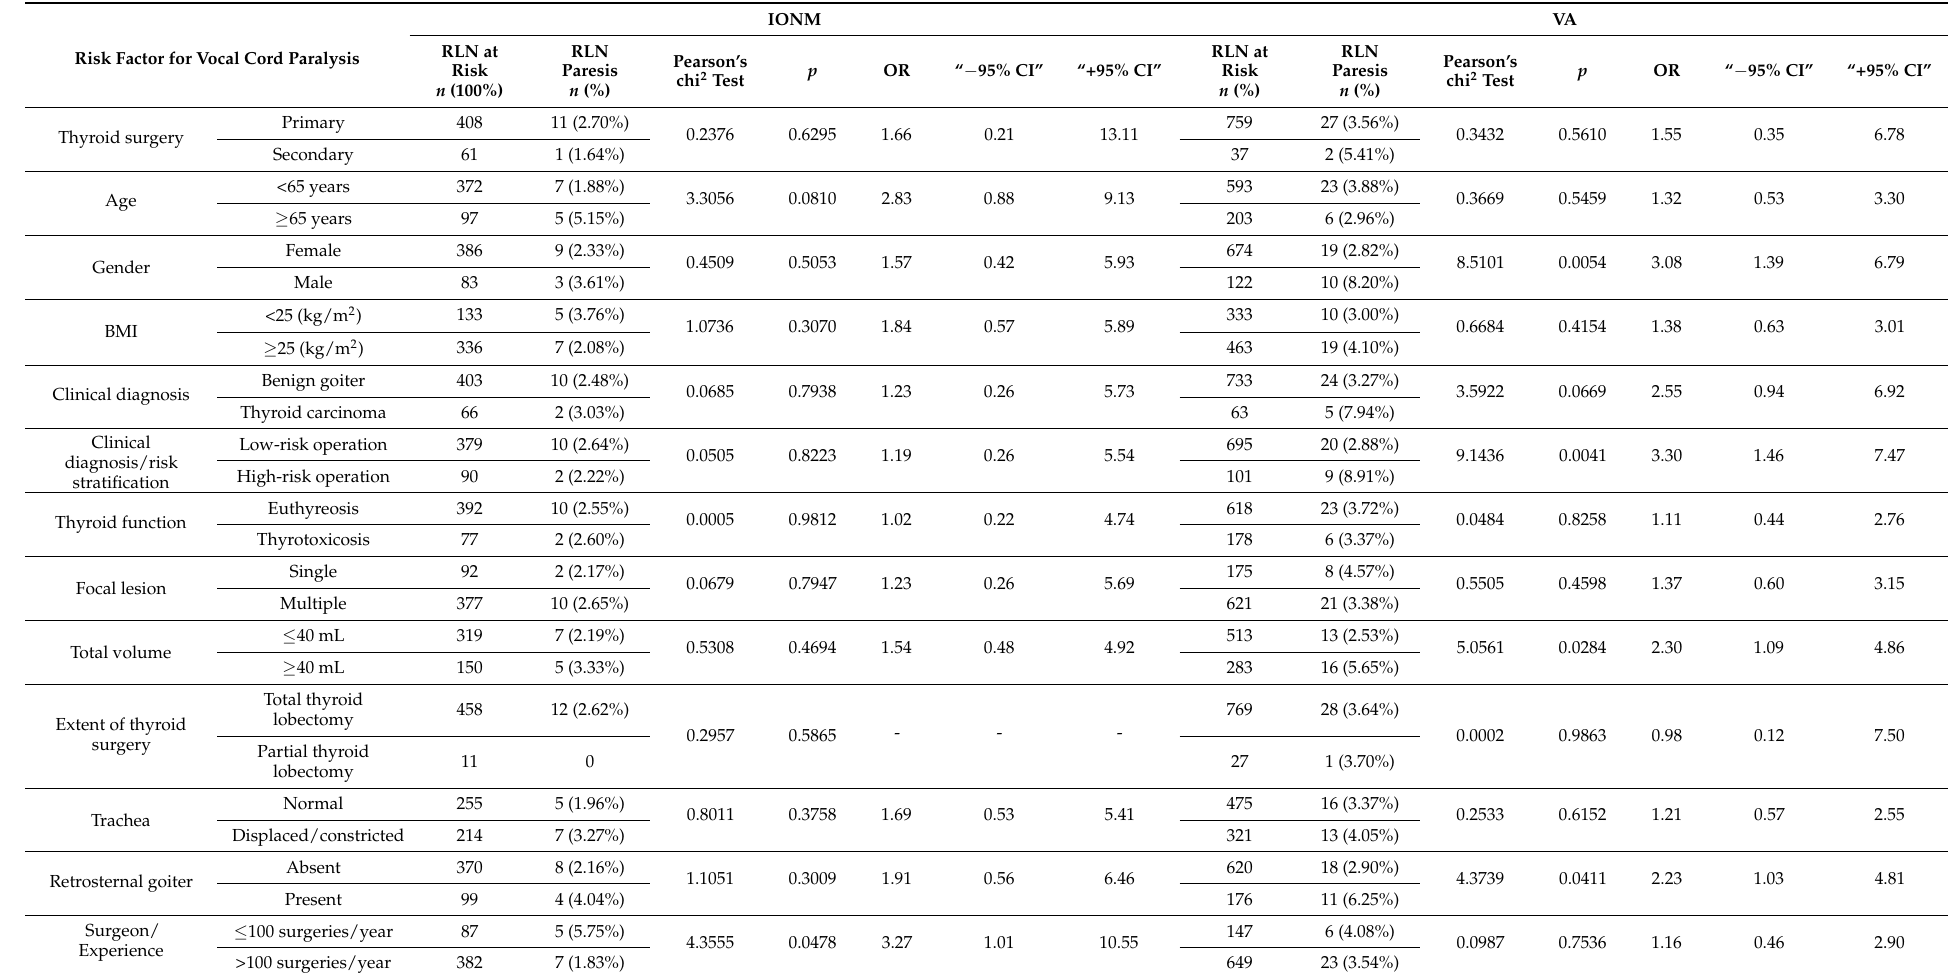
Table 5. Influence of risk factors for vocal cord paralysis in visual RLN identification alone—Pearson’s chi 2